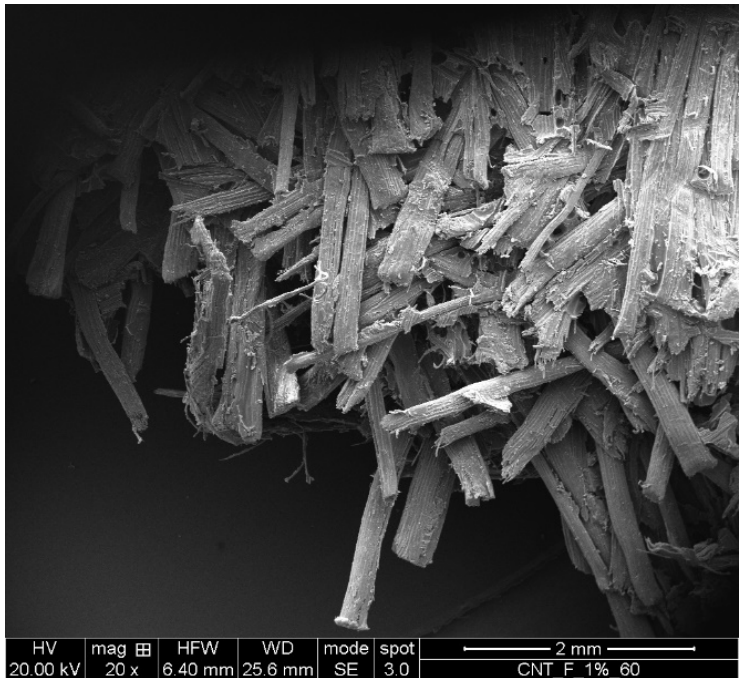
Figure 2. SEM micrographs of the fracture surfaces of the biocomposite subjected to static tensile